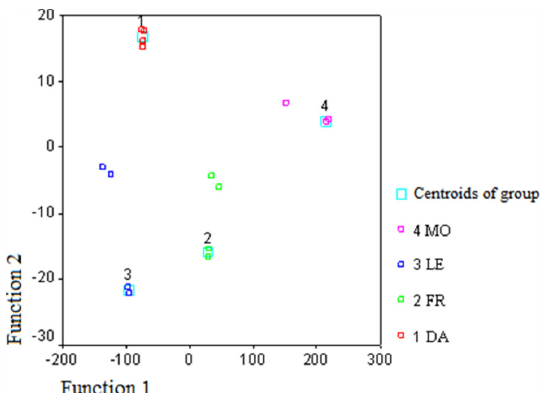
Figure 3. Discriminant function plot of the first two functions obtained using volatile percent composition of monovarietal EVOO samples (DA, Dolce Agogia; FR, Frantoio; LE, Leccino; MO, Moraiolo).